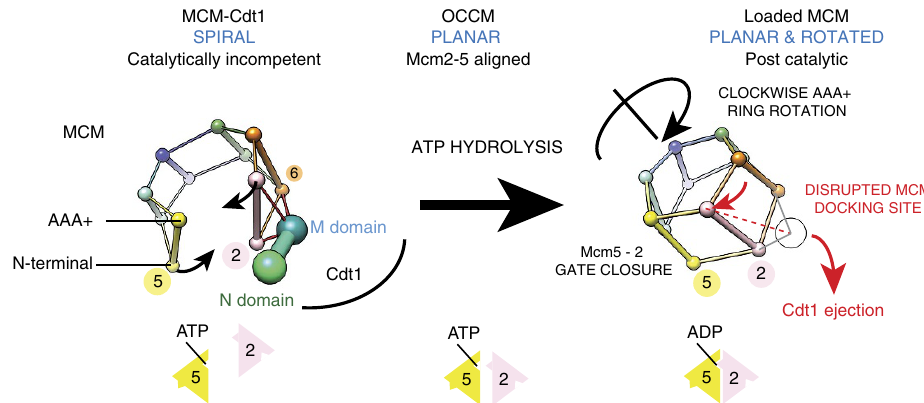
Figure 5 | A mechanism for ATPase-mediated Cdt1 ejection during MCM loading. Cdt1 binds to the side of Mcm2 and Mcm6, interacting both with N-terminal and AAA þ ATPase elements. Cdt1 stabilizes a topologically open left-handed spiral configuration of MCM, with a discontinuity between the Mcm5 and Mcm2 subunits, disrupting a functionally essential AAA þ ATPase site. DNA recruitment mediated by ORC and Cdc6 (OCCM formation) planarizes the MCM ring, reconstituting the Mcm5–2 ATPase site, which becomes competent for ATP hydrolysis. Conversion to a post-catalytic, loaded MCM involves the clockwise rotation of the AAA þ ATPase tier. This conformational change probably disrupts a Cdt1 docking site on Mcm2, promoting ATPase-dependent Cdt1